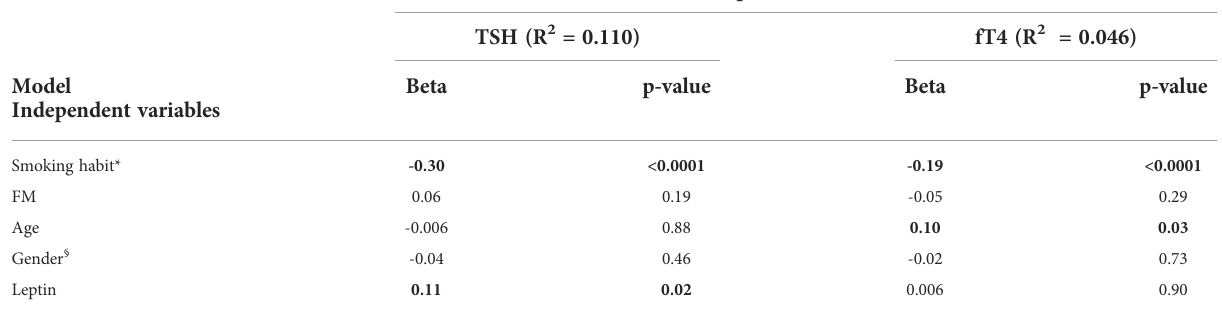
TABLE 5 Multivariable linear regression analysis showing independent predictors for TSH and fT4 levels in the subgroup of patients with leptin